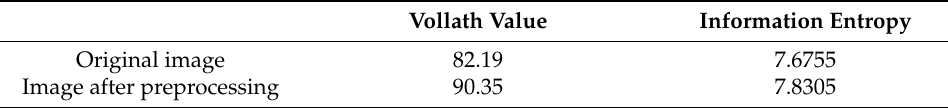
Table 2. Image definition and quality